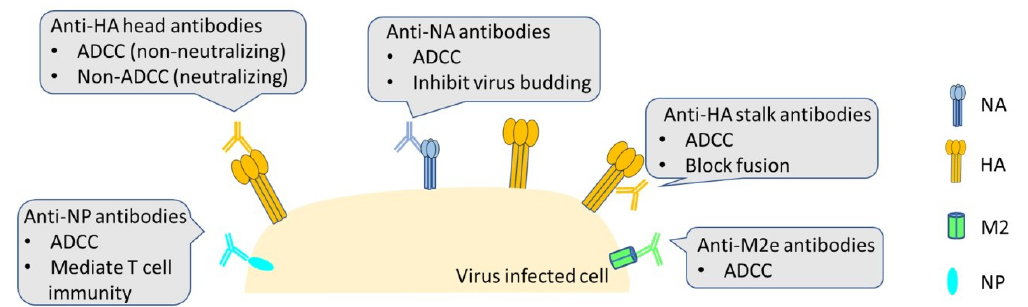
Figure 4. ADCC- mediating antibodies (ADCC-Abs) targeting di ff erent influenza antigens. HA, NA and M2 are the surface-exposed proteins and they are capable of inducing ADCC-Abs. Antibodies targeting the conserved epitopes in these proteins confer broad protection against divergent viruses. NP expressed on the surface of the influenza-infected cell serves as a promising target for